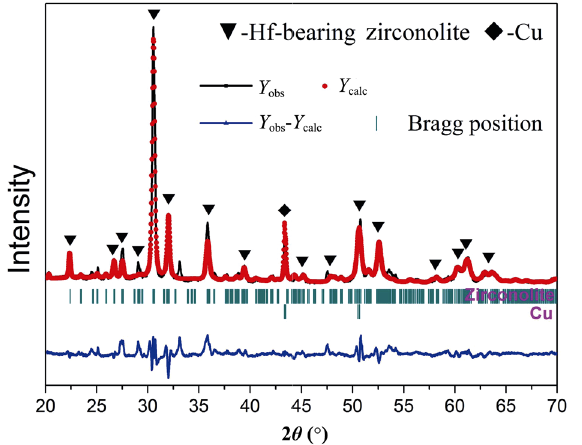
Fig. 4 Rietveld refined XRD pattern of the Cu-Hf-0.6